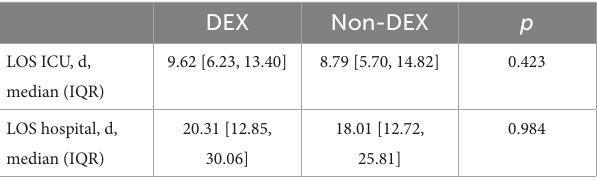
TABLE 5 Comparison of LOS ICU and hospital of survivors within 90 days in DEX and non-DEX group.